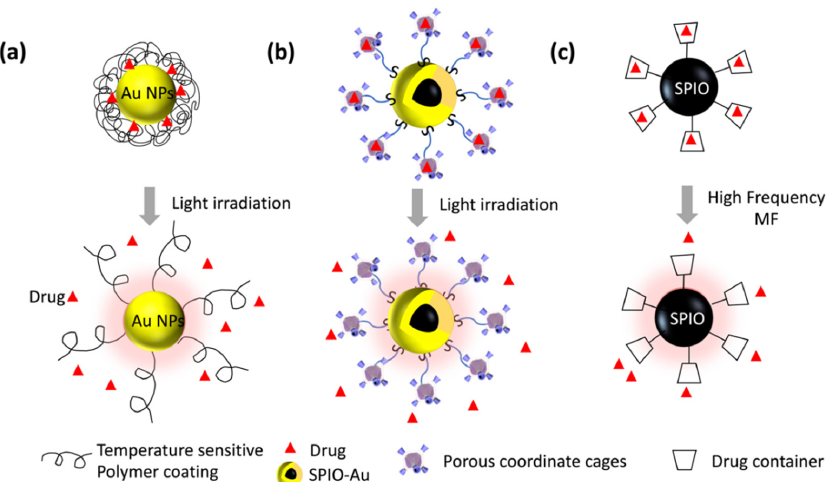
Figure 6. Schematic of different stimulus-type-triggered drug release: ( a ) light-stimulated drug release from Au NPs and drug-encapsulated temperature-sensitive polymers via plasmonically gen- erated heat; ( b ) light-stimulated drug release from PCC-conjugated SPIO–Au NPs via plasmonically generated heat; ( c ) high-frequency MF-triggered drug release from drug container conjugated with SPIO NPs via hyperthermia